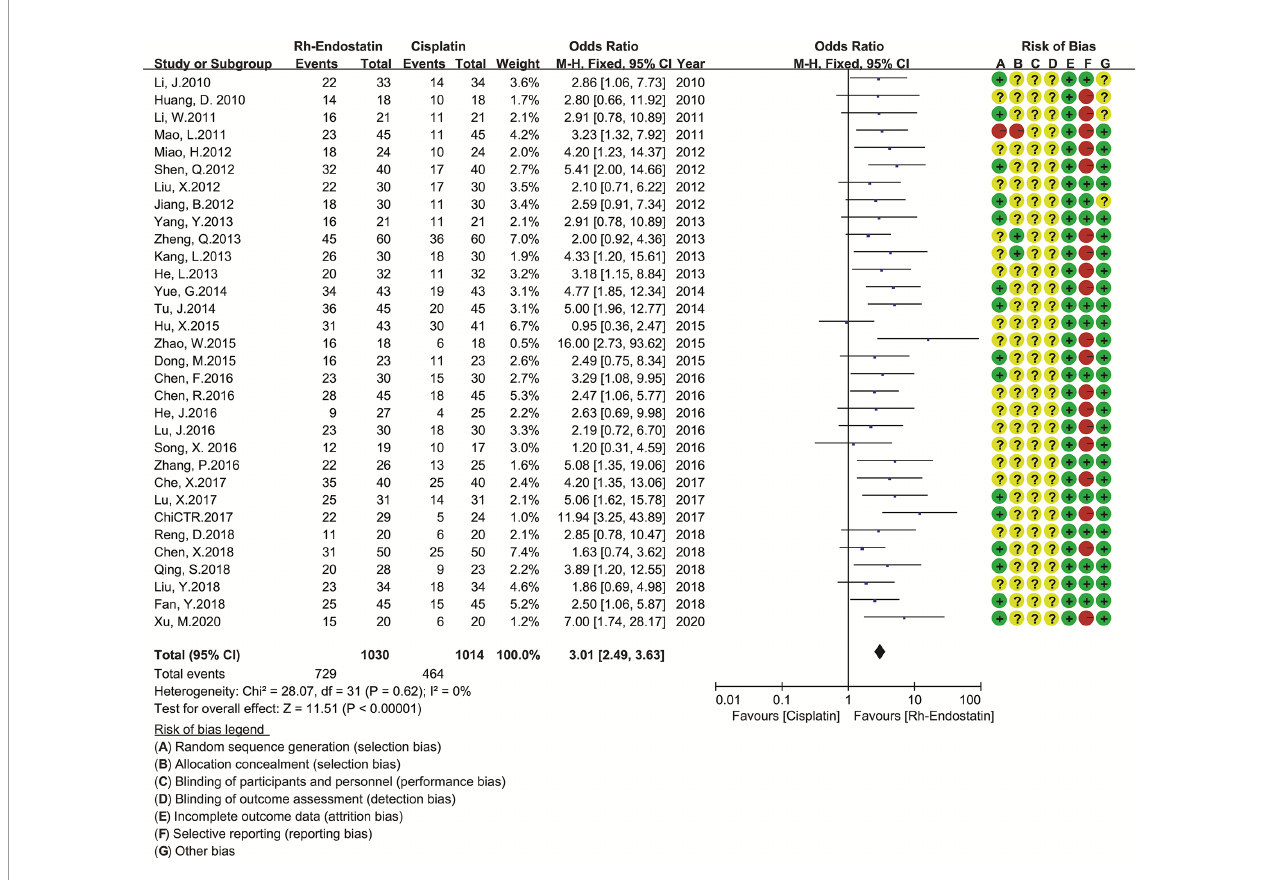
FIGURE 5 | The forest plot of quality of life.